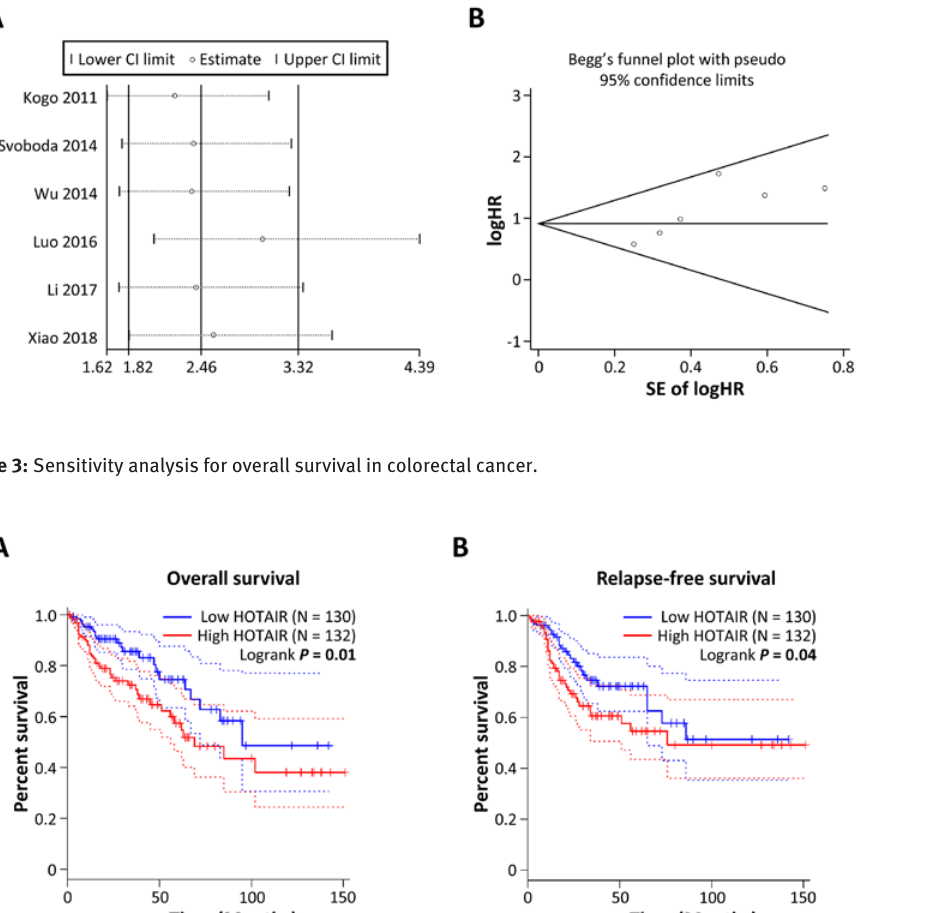
Figure 4: Validation the prognostic value of HOTAIR in the TCGA database. (A) HOTAIR and overall survival. (B) HOTAIR and relapse-free